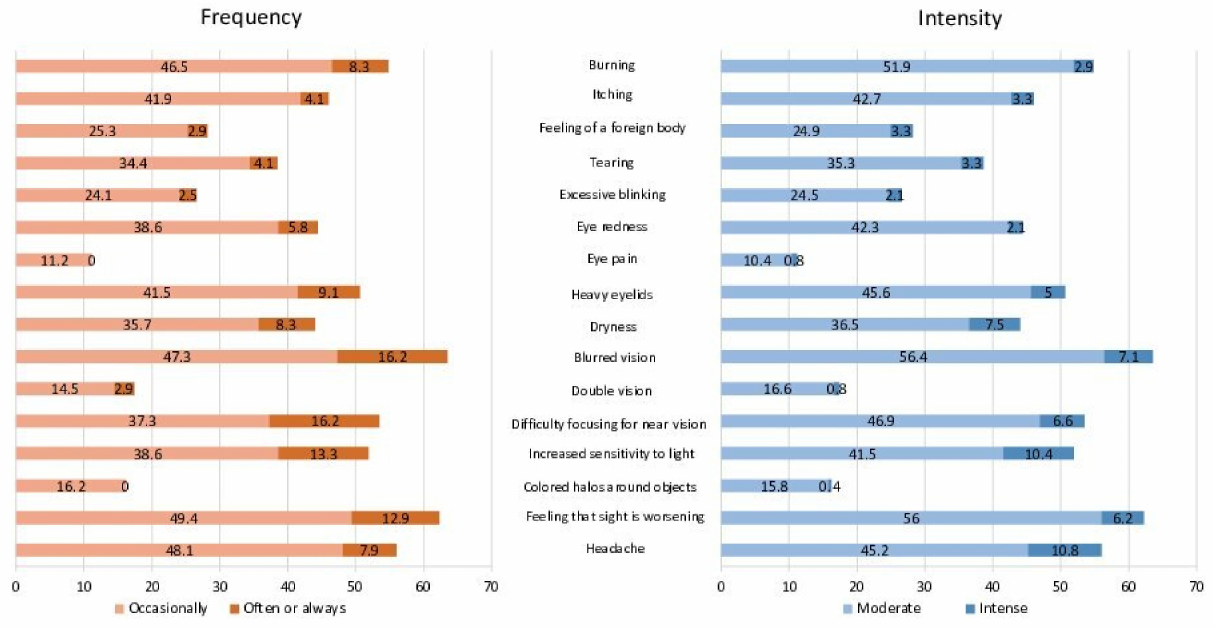
Figure 5. Percentage of workers who presented each symptom according to frequency and